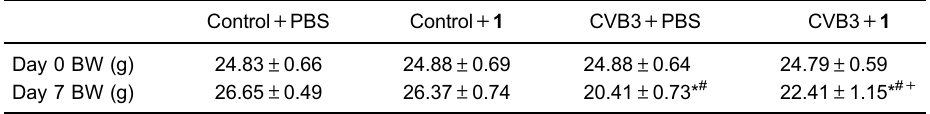
Data are reported as means ± SD. BW: body weight. CVB3: Coxsackie virus B3; PBS: phosphate